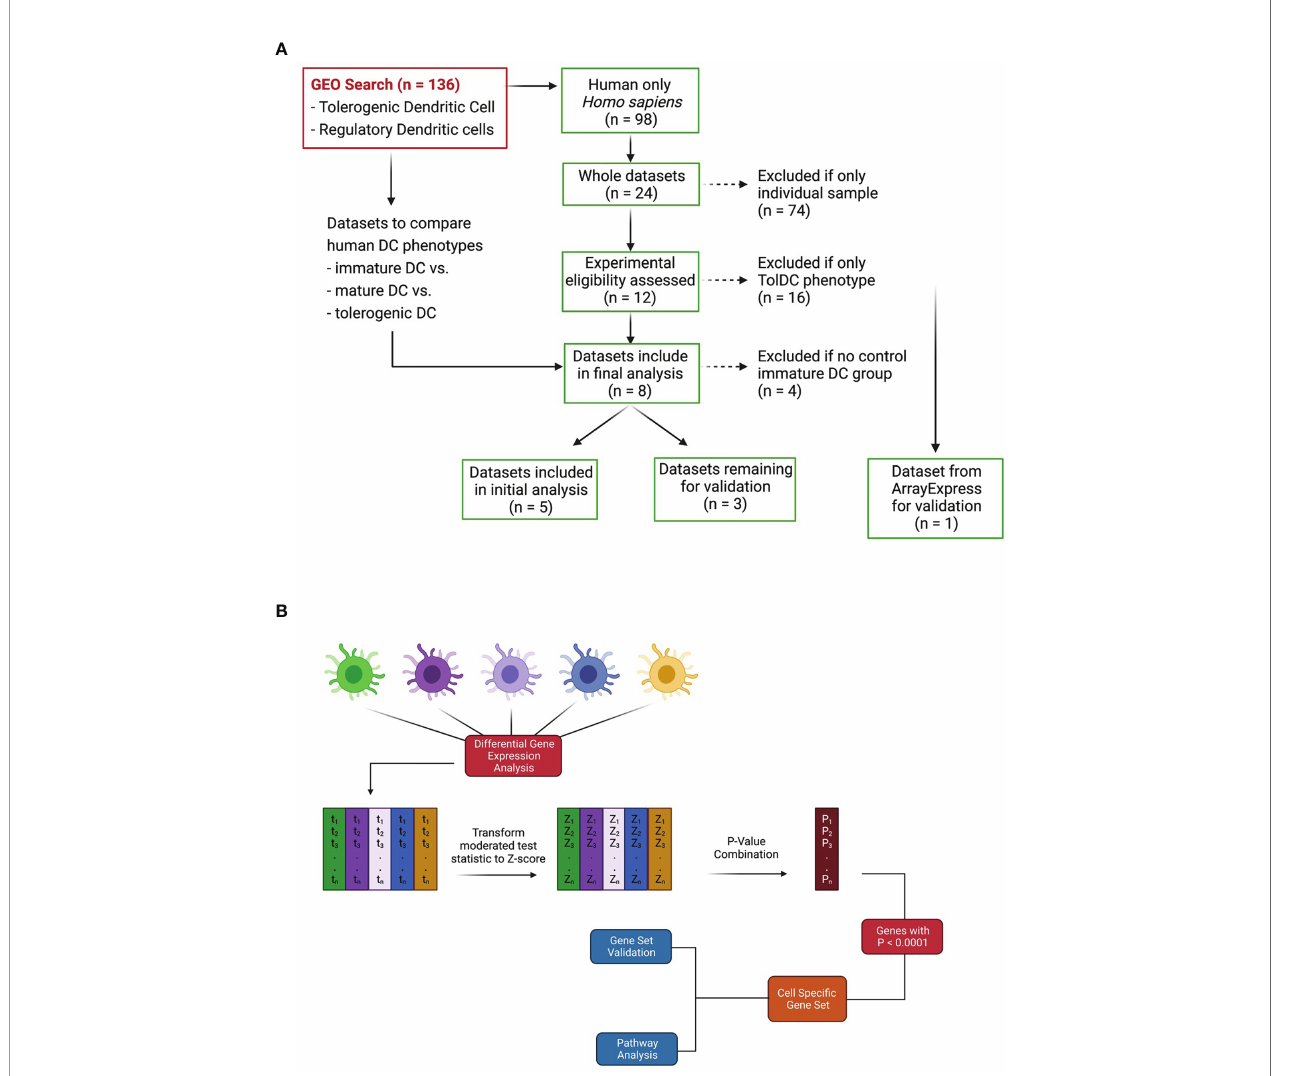
FIGURE 1 | Dataset identi fi cation and work fl ow for tolDC gene analysis. (A) Flowchart demonstrating relevant GEO search with inclusion and exclusion criteria. (B) Pipeline for generating tolDC, AADC and mature DC gene